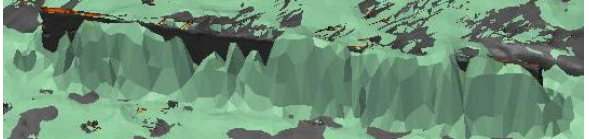
Figure 10. Retaining wall of the overflow area 3 of polder 2, UAS-DSM in green and TLS-DSM in gray (perspective view from the south)